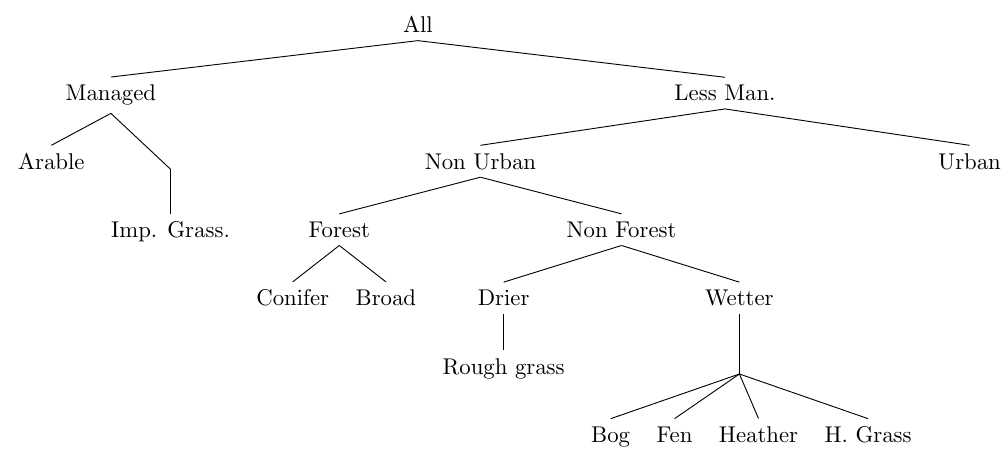
Fig. 5. Hierarchical classification of the ten land cover classes used to define groups for statistical analysis using orthogonal contrasts. Less Man. refers to less managed land cover types in contrast to more intensively managed (agricultural)